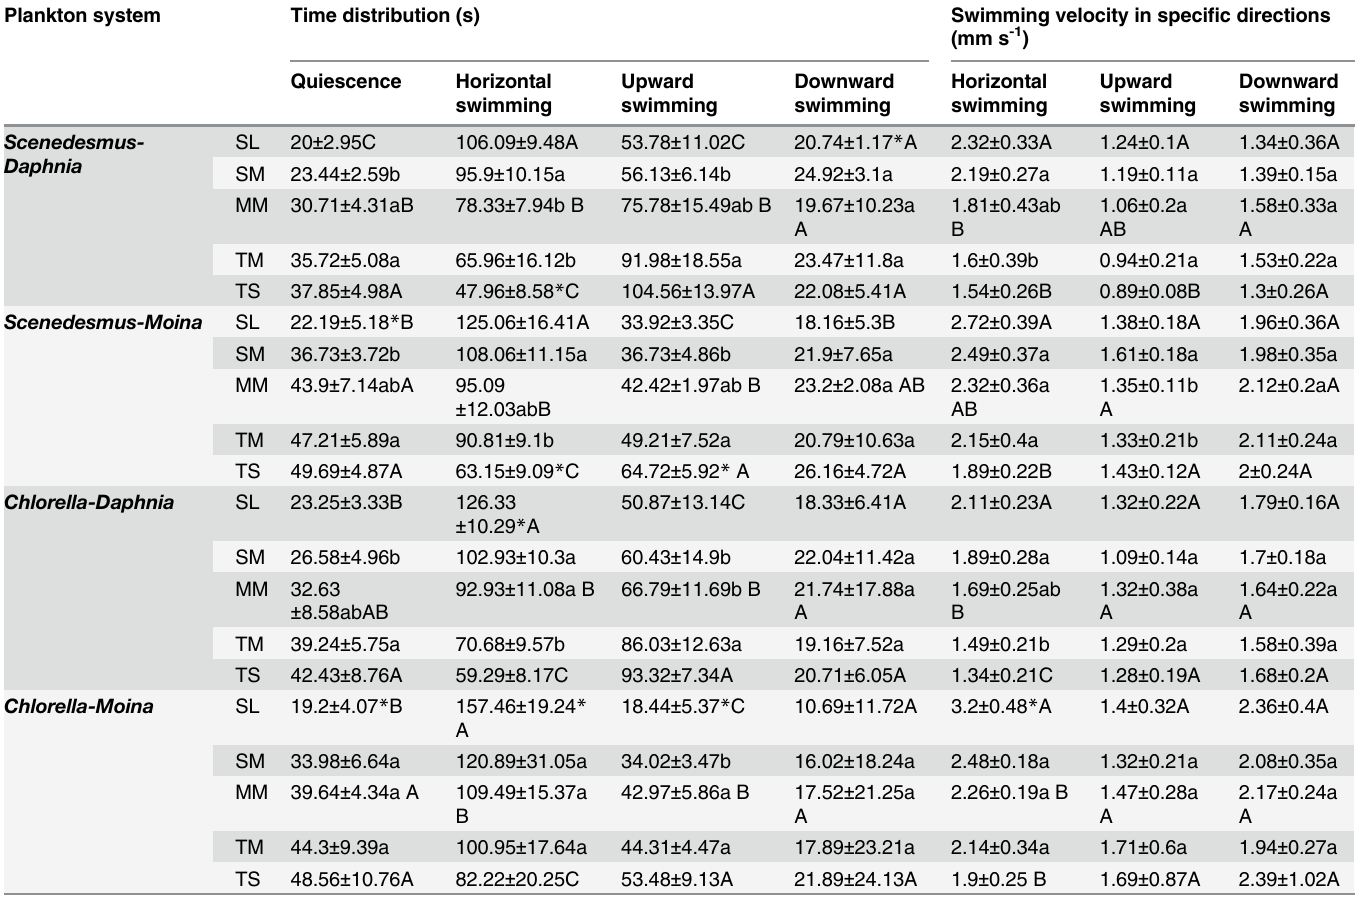
Table 2. Swimming activity of Daphnia magna and Moina micrura in different algae-grazer systems under different microcosm conditions. Plankton system